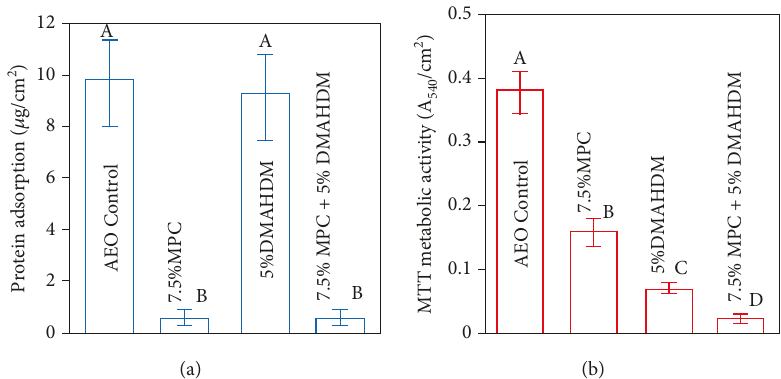
Figure 6: Protein adsorption and bio fi lm metabolic activity. (a) Protein adsorption onto self-etch adhesive ( mean ± sd ; n = 6 ). AEO with 7.5% MPC+5% DMAHDM had much less protein adsorption, which was about 5% that of AEO control ( p < 0 05 ). Bars with dissimilar letters indicate values that are signi fi cantly di ff erent from each other ( p < 0 05 ). (b) Bio fi lm metabolic activity on disks cultured for 2 days ( mean ± sd ; n = 6 ). Metabolic activity of bio fi lms on AEO with 7.5% MPC+5% DMAHDM was reduced to 5% that of AEO control ( p < 0 05 ). Values with dissimilar letters are signi fi cantly di ff erent from each other ( p < 0 05 ). (Adapted from reference [63], with